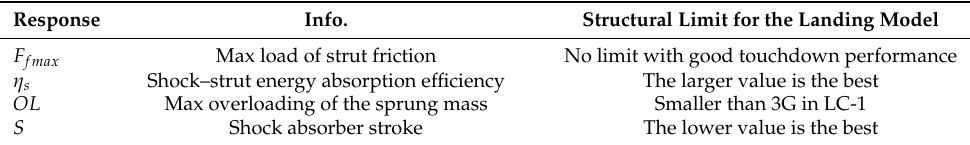
Table 7. The information of four landing dynamic